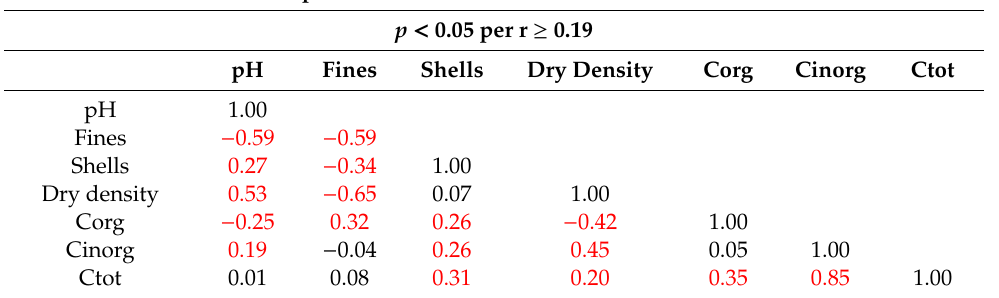
Table 3. Non-parametric Spearman’s coe ffi cients between carbon compounds and some parameters of surface sediments of all the considered lagoons and ponds. In red, significant values: p < 0.05 for r ≥